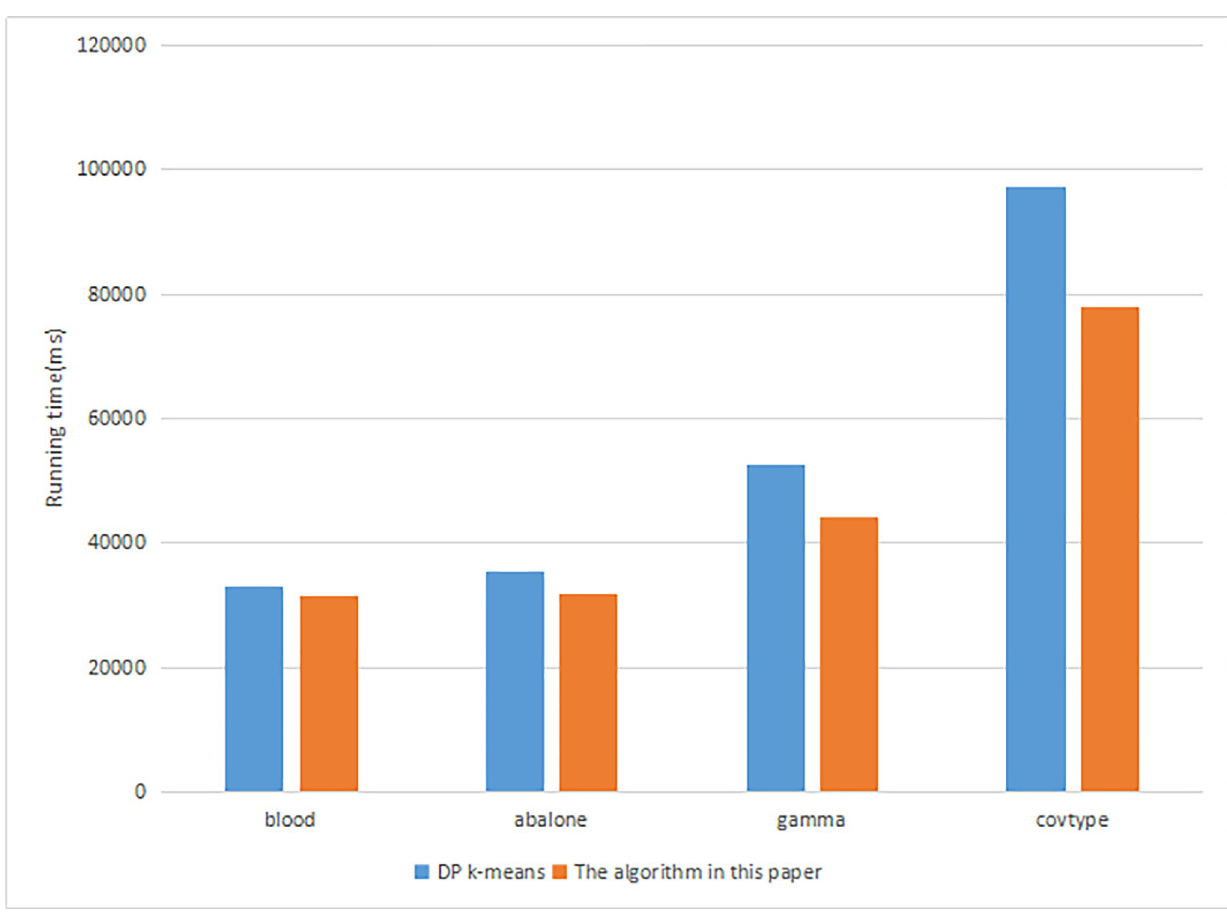
Fig 5. Parallel efficiency comparison in the algorithm in this paper and DP